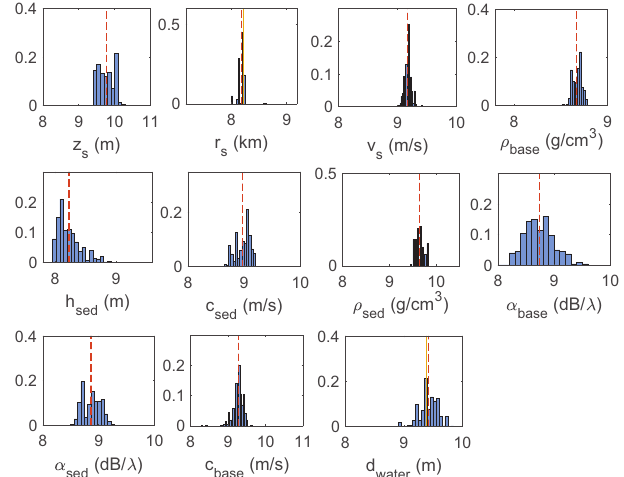
Figure 8. Normalized histograms of EnKPF particles for source and geoacoustic parameters at t = 76 min. The vertical dashed lines are estimated values and solid lines in the second and last chart are measured